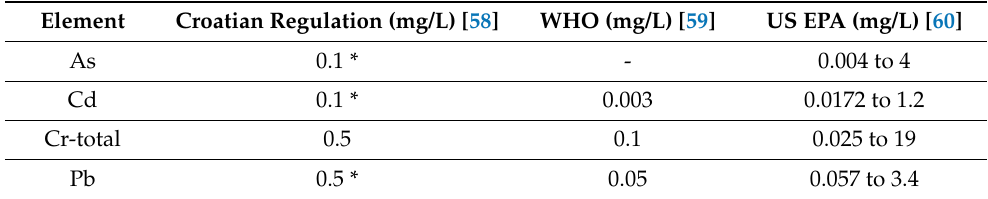
Table 8. Limit values of heavy metal emission for surface wastewater discharges. Element Croatian Regulation (mg/L) [58] WHO (mg/L) [59] US EPA (mg/L) [60] As 0.1 * - 0.004 to 4 Cd 0.1 *